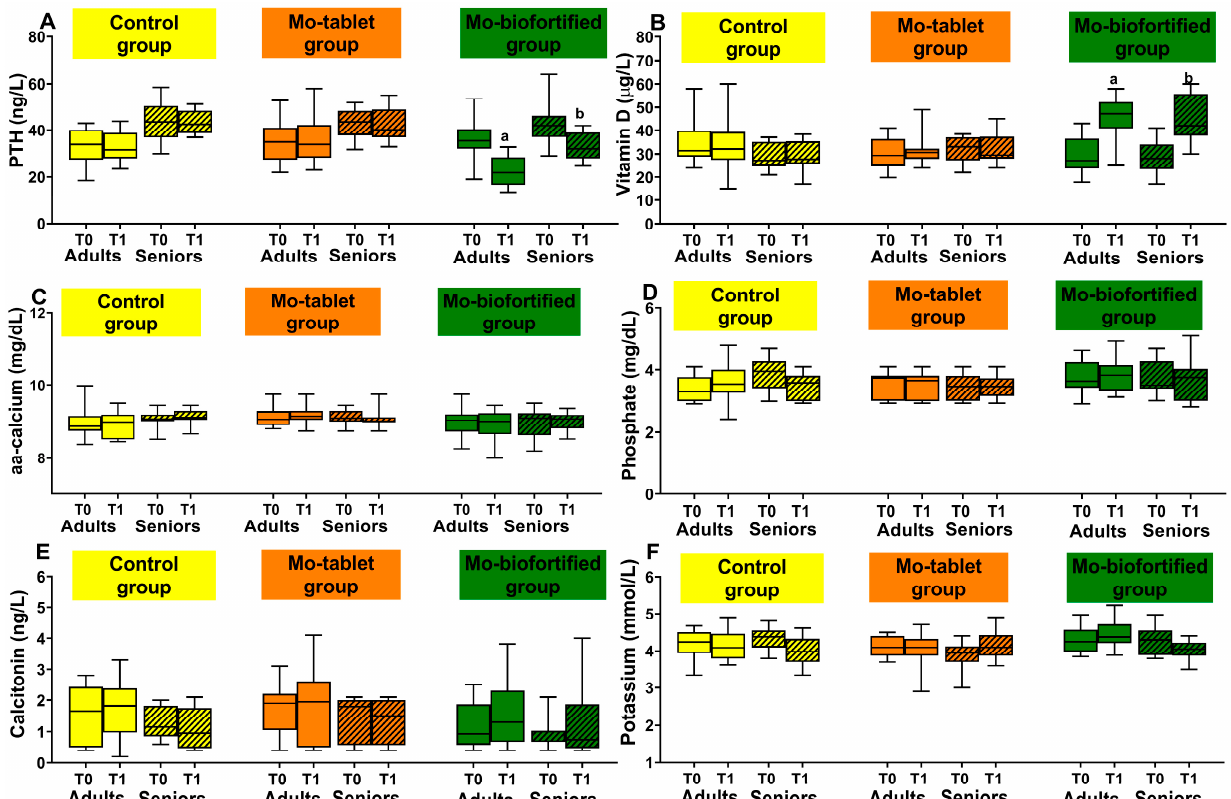
Figure 4. Bone metabolism markers were measured at baseline and after 12 days in the three groups: the control group (supplemented with 100 g a day of lettuce), the Mo-tablet group (supplemented once a day with molybdenum in tablet form) and the Mo-biofortified group (supplemented with 100 g a day of molybdenum-enriched lettuce). ( A ) Box plot showing concentration of PTH in control, Mo-tablet and Mo-biofortified groups. ( B ) Box plot showing concentration of vitamin D in control, Mo-tablet and Mo-biofortified groups. ( C ) Box plot showing concentration of aa calcium in control, Mo-tablet and Mo-biofortified groups. ( D ) Box plot showing concentration of phosphate in control, Mo-tablet and Mo-biofortified groups. ( E ) Box plot of calcitonin in control, Mo-tablet and Mo-biofortified groups. ( F ) Box plot showing concentration of potassium in control, Mo-tablet and Mo-biofortified groups. The letter a denotes a significant difference ( p < 0.05) of Mo-biofortified lettuce compared with the control (T0 and T1), Mo tablet (T0 and T1) and T0 of Mo-biofortified lettuce in the adult group. The letter b denotes a significant difference ( p < 0.05) of Mo-biofortified lettuce compared with the control (T0 and T1), Mo tablet (T0 and T1) and T0 of Mo-biofortified lettuce in the senior group.